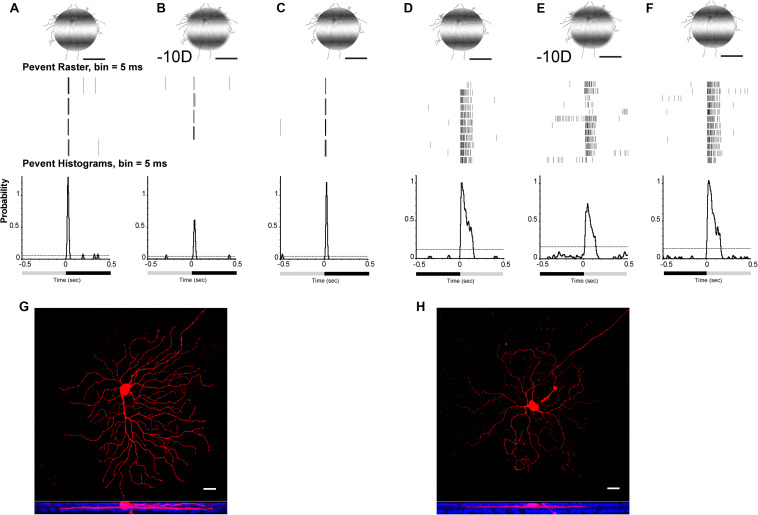
Defocused images altered the signaling responses in RGCs. Perievent rasters histogram of OFF (A–C) α-RGC and ON (D–F) α-RGC responses (middle images) to 0.5-s flashed 0.002 cycles/degree light stimuli. Light spot was maintained in 125 μm when defocused –10 D (B,E), whereas light intensity decreased from I = 5.1 × 104 to 5.0 × 104R*/rod/s. OFF α-RGC light responses decreased after a defocused image was projected (B). Peristimulus time histogram of the OFF α-RGC showed that the probability of spikes decreased from 1.28 to 0.61 (–10-D defocus), then back to 1.21 after refocusing. ON α-RGC (D) decreased from 1.05 to 0.7 (–10-D defocus) and then back to 1.05 after refocusing. (G) and (H) showed OFF α-RGC (A–C) and ON α-RGC (D–F) with Neurobiotin filling after recording. Lower images show the ganglion cell branched in OFF and ON layer with anti-ChAT labeling (blue). Scale bar: (A–F) 75 μm, (G,H) 20 μm.